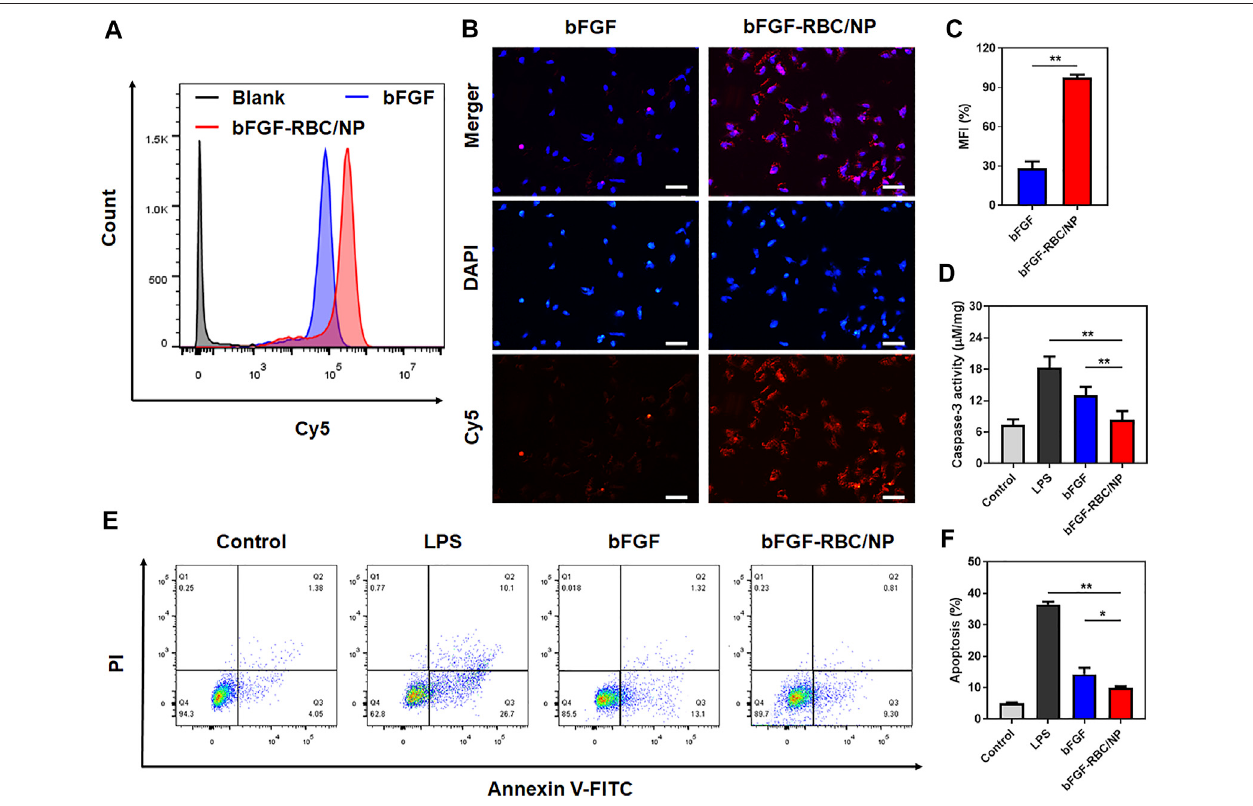
FIGURE 2 | In vitro cellular uptake and anti-apoptotic capacity of bFGF-RBC/NP. The cells were treated with bFGF and bFGF-RBC/NP (50 ng/ml) for 4 h, and the cellular uptake wasanalyzed by (A) fl ow cytometry and (B) laser scanning confocal microscopy. (C) Mean fl uorescent intensity (MFI) of each group. The LPS-stimulated (1 μ g/ml) H9c2 cells were treated with bFGF and bFGF-RBC/NP (50 ng/ml) for 24 h. (D) Caspase-3 activity of each group. (E) Apoptosis was assessed by fl ow cytometry and (F) quantitative analysis. Data are expressed as the mean ± SD ( n = 3). Scale bar = 50 um. * p < 0.05 and ** p <